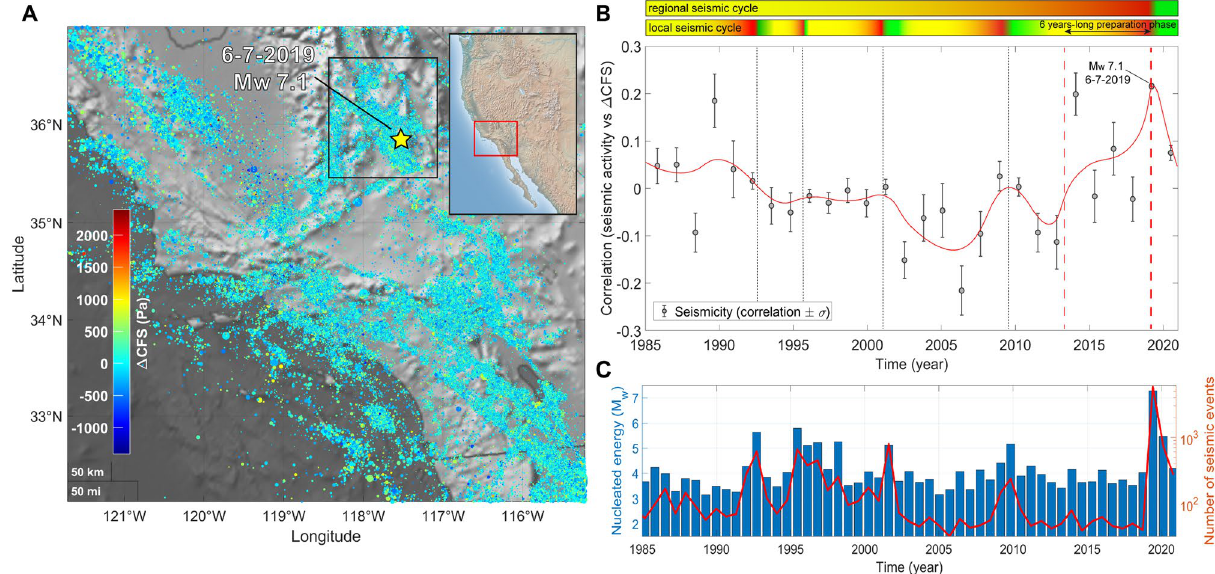
Figure 1. ( A ) (cid:31) CFS map for seismicity in Southern California, SCEDC Catalog, 1985−2021, M L ≥ 1.0. Seismicity occurs, on average, at slightly positive (cid:31) CFS values. The map is realized using the functions “geoscatter” and “geobasemap” in the Matlab environment 63 . ( B ) Correlation ρ between (cid:31) CFS and seismicity in the Ridgecrest District, California, between 1985 and 2021. The scatter plot is realized by taking into account earthquakes happened at latitude 35.2°−36.4° N, longitude 117.0°−118.2° W and -2−20 km deep, M L ≥ 1.0. A preseismic phase featured by an increase of the correlation is detected before the Ridgecrest seismic sequence, mainshock 6/7/2019, M w 7.1. The red line is a weighted smoothing spline. Two horizontal color bars above the scatter-plot show nested “seismic cycles” whose phases are highlighted by different colors (green for the post-seismic phase, the interseismic one is in yellow and the coseismic phase is in red). ( C ) Histogram of energy nucleated by earthquakes with M L ≥ 1.0 (blue bars) and plot of the number of recorded seismic events (red